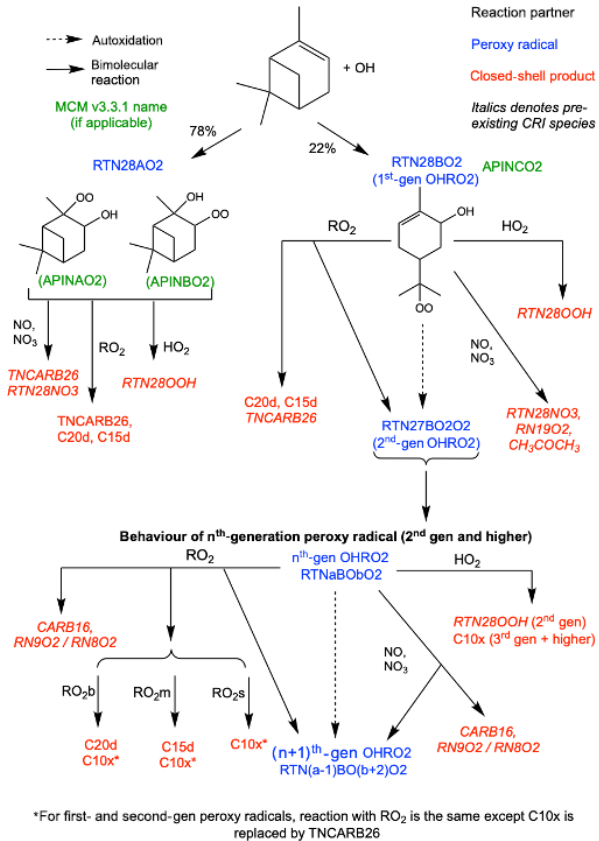
Figure 2. Schematic of additions to CRI v2.2 to represent autoxi- dation and HOM formation via OH oxidation. HOMs can be pro- duced via reaction with HO 2 and RO 2 , while reaction with NO, NO 3 and RO 2 can produce alkoxy radicals which can fragment or isomerise. The RO 2 pool is split into subsections covering big (RO 2 b), medium (RO 2 m) and small (RO 2 s) peroxy radicals to fa- cilitate addition of accretion product